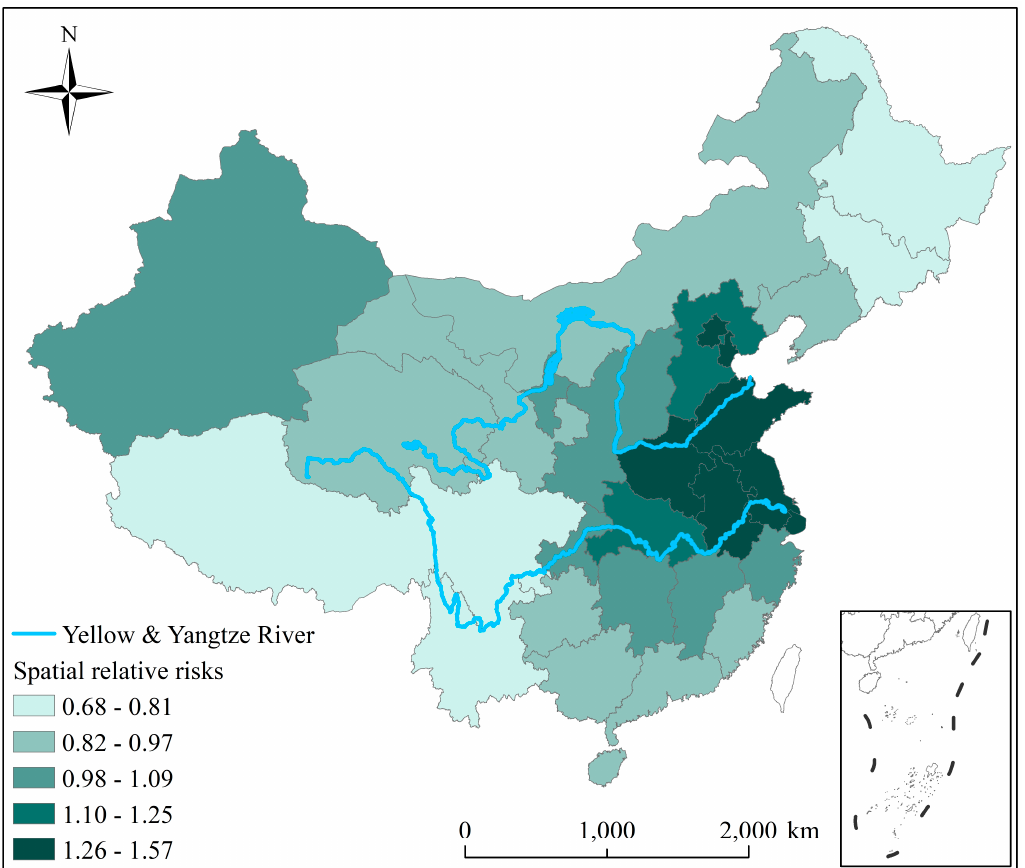
Figure 4. Spatial relative risks of PM 2.5 concentrations in each province across China.